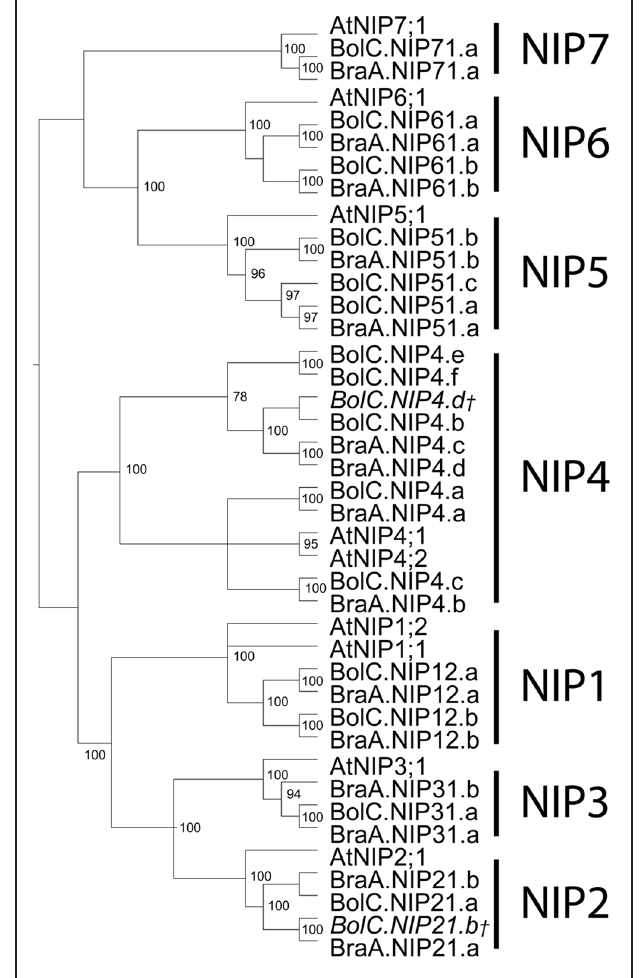
FIGURE 6 | Phylogeny of NIPs. Phylogenetic tree derived from NIP cDNA sequences of B. oleracea , B. rapa, and A. thaliana using Bayesian phylogenetic inference. Numbers beside the nodes indicate the posterior probability values > 75%. Gene IDs which are written in italics and/or marked with a cross do not encode for full-length AQPs due to mutations leading to frameshifts or stop codons in their